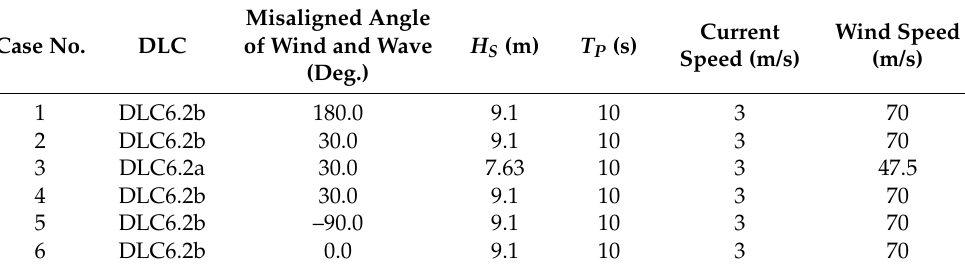
Table 9. Environmental Variables for Jacket Substructure Analysis.